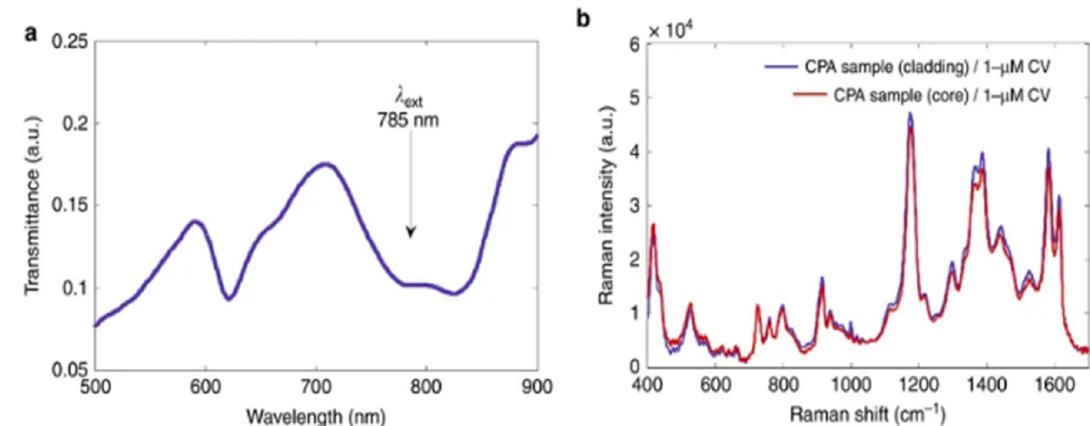
Figure 22. ( a ) Transmittance of the CPA sample; ( b ) SERS spectrum by illuminating the cladding and core zones of the CPA Figure 22. (a) Transmittance of the CPA sample; (b) SERS spectrum by illuminating the cladding and core zones of the sample. Reprinted with permission of [84]. CPA sample. Reprinted with permission of [84].